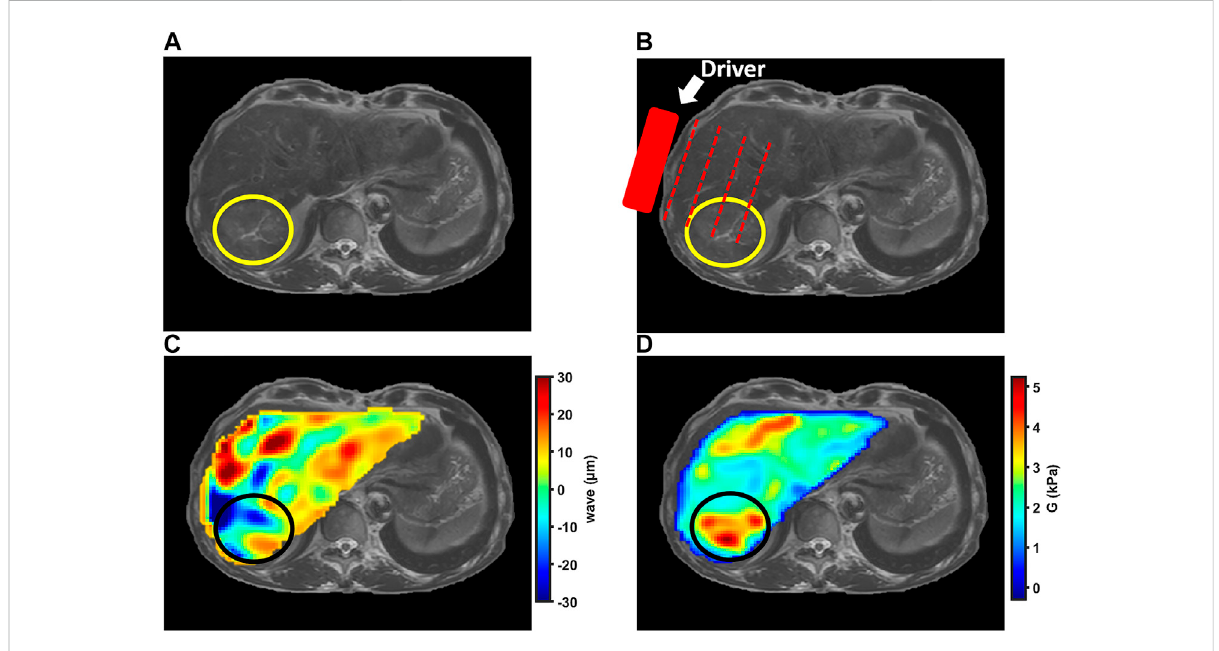
FIGURE 1 MREexaminationinpatientwithhepatocellularcarcinomaindicatedbythecircle. (A)